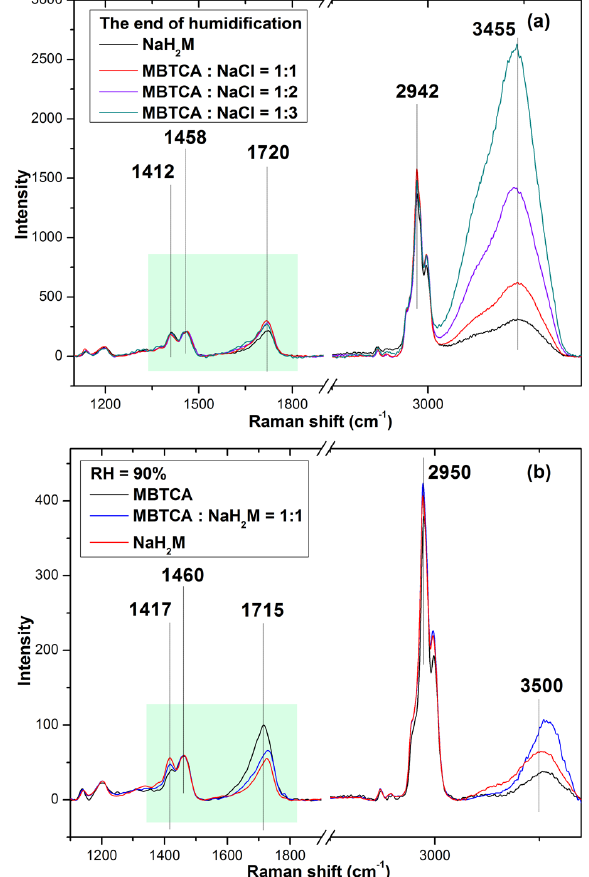
Figure 6. (a) Raman spectra of pure NaH 2 M and mixture aerosols with mixing ratios of MBTCA:NaCl = 1:1, 1:2, and 1:3 obtained at the end of the humidification process, which were normalized to the CH 3 peak at 1458cm − 1 , and (b) Raman spectra of pure MBTCA, mixture of MBTCA:NaH 2 M = 1:1, and pure NaH 2 M, which are normalized to the CH 3 peak at 1460cm − 1